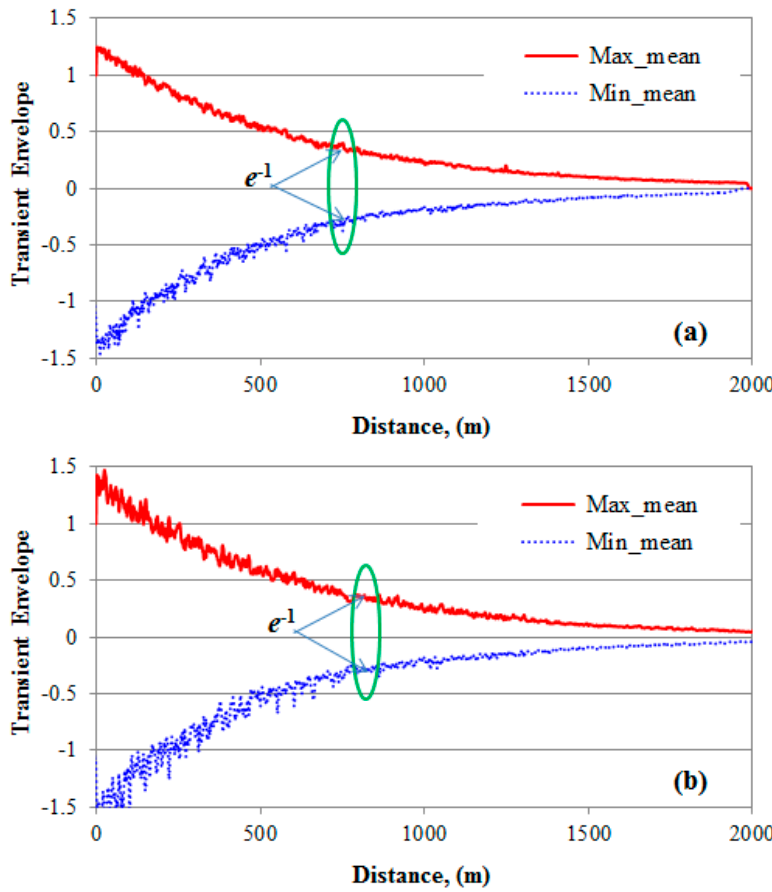
Figure 12. Results of the random disorder case with λ w /2 λ b =1: ( a ) uniform distribution and α = 0.2 m − 1 ; ( b ) triangular distribution and α = 0.2 m − 1 .